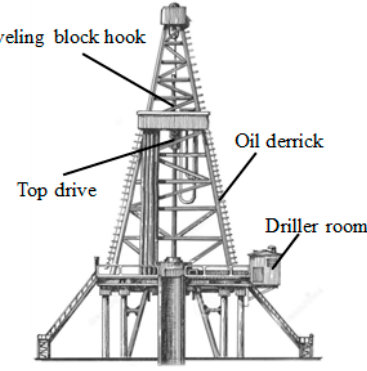
Figure 1. Drilling rig hoisting platform.